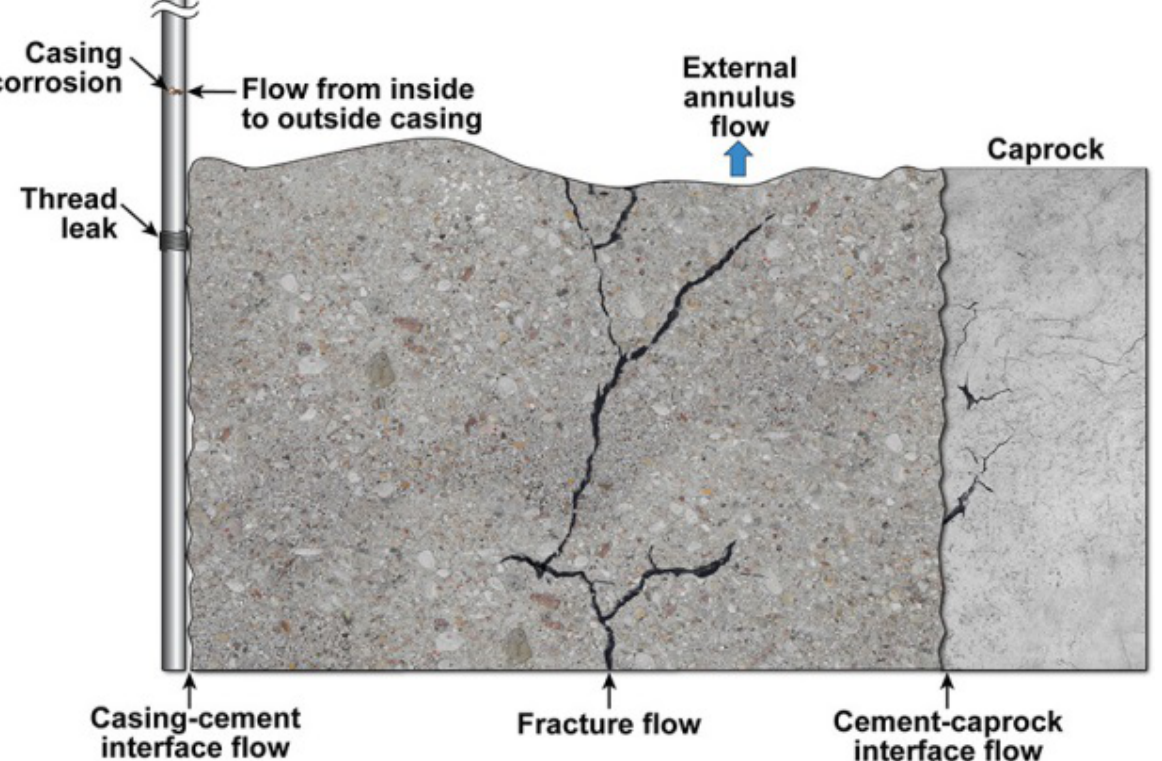
Figure 3. Schematic diagram of CO 2 flow in wellbore, formation rocks and fractures [32].